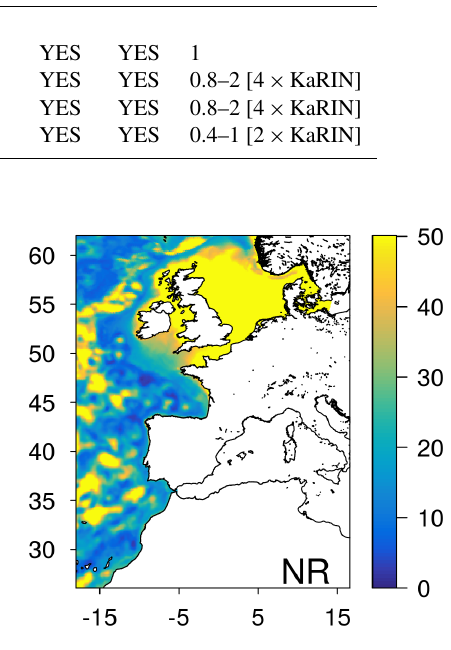
Figure 3. SSH variance (in cm 2 ) in the NR over the period from February to December 2009. nadir altimeters, ER ∗ is defined as the percentage decrease of the error with respect to OSSE1,